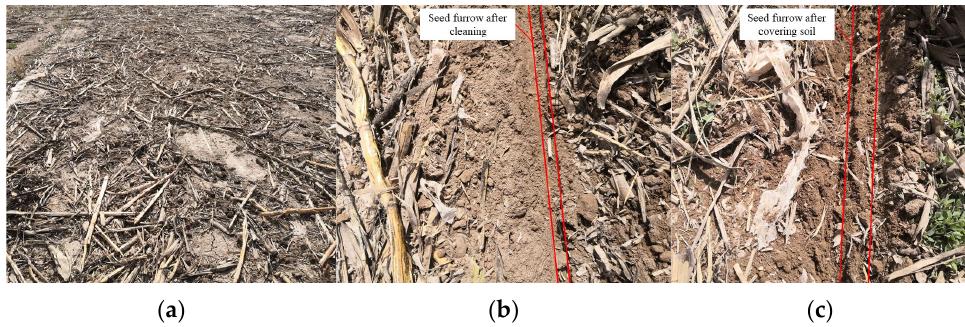
Figure 17. Effect of seed furrow after clearing. ( a ) Before clearing; ( b ) Seed furrow after clearing; ( c ) Seed furrow after covering soil. Table 4. Field test results of seed furrow clearing effect.